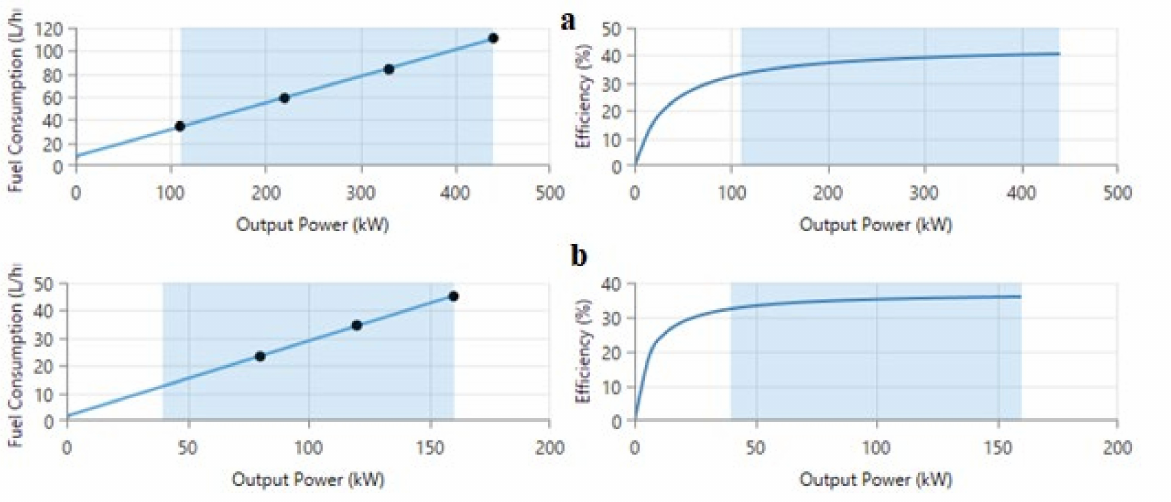
Figure 7. The fuel consumption and efficiency curves of 440 kW ( a ) and 160 kW ( b ) diesel